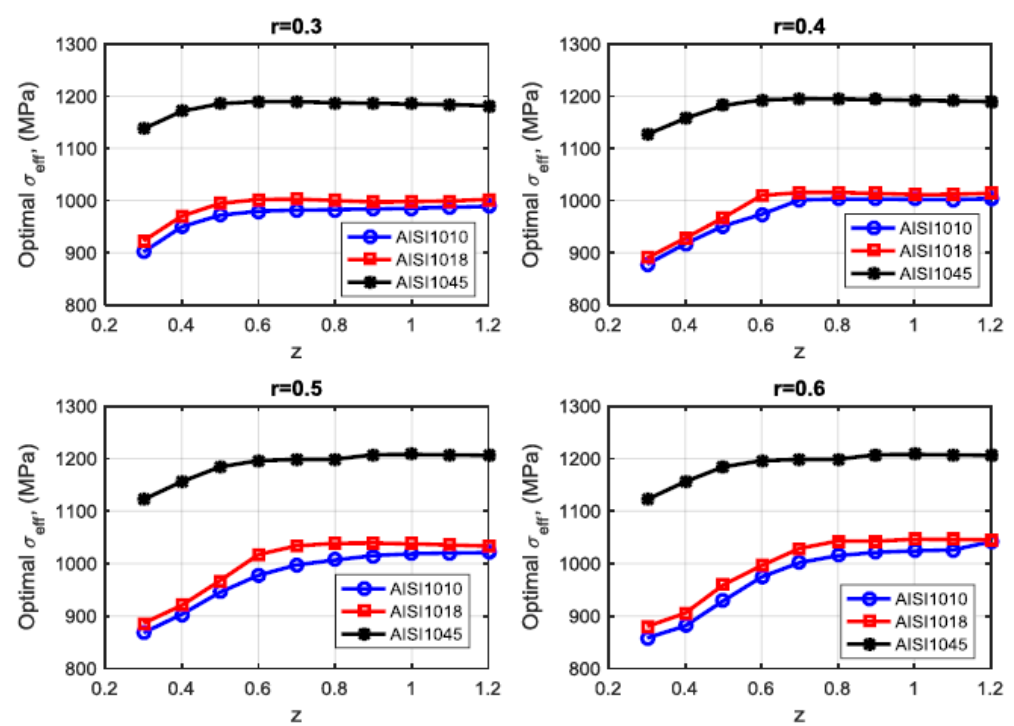
Figure 14. Comparison of optimal values of effective stress of different steels.